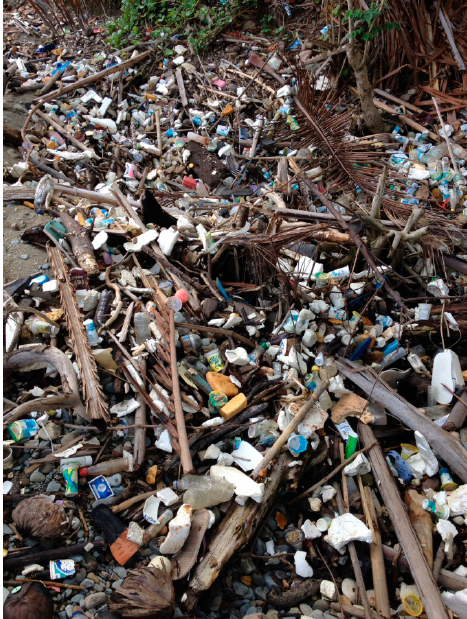
Figure 1. Beach area in Ambon, Indonesia contaminated with plastic waste. Image provided by Chris Mason-Parker.